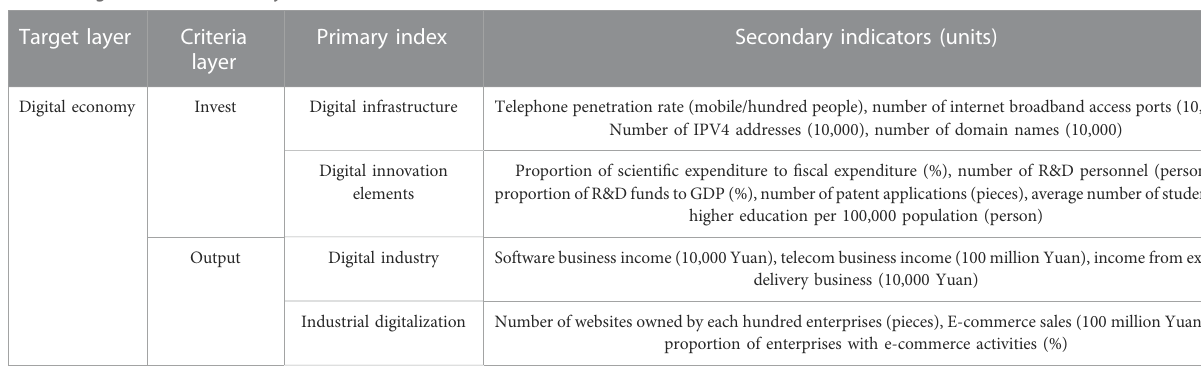
TABLE 1 Digital economic index system. Target layer Criteria Digital